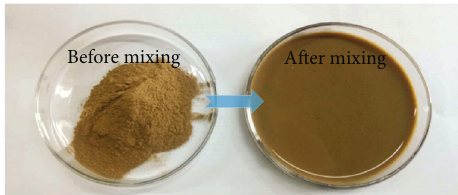
Figure 1: States of inorganic sealing materials before and after mixing with